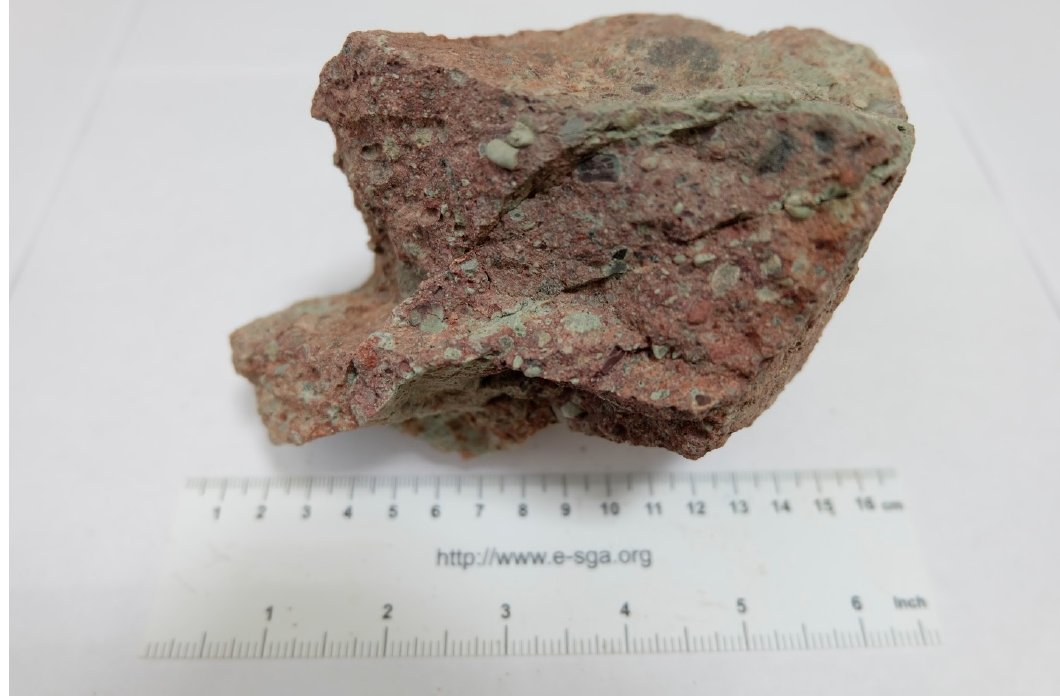
Figure A5. Tuff (sample ID 33CA_13), Tuffaceous sedimentary rocks of the crater, Upper Devonian—Middle Carboniferous ( iD 3 -C 2 ), Arkhangelskaya pipe, Lomonosov diamond deposit.